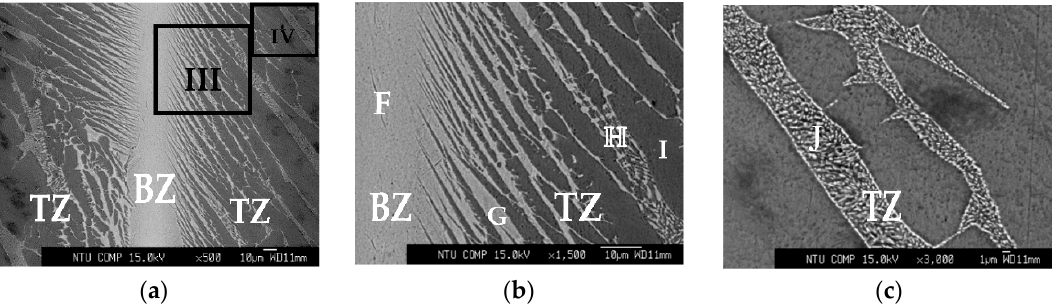
Figure 5. EPMA BEIs of CP-Ti/40Ti-35Ni-25Nb/CP-Ti joint brazed at 1100 °C for 600 s: ( a ) cross section overview, ( b ) higher magnification of location III in ( a ), ( c ) higher magnification of location IV in ( a ). Table 2. EPMA quantitative chemical analysis results in Figure 6.